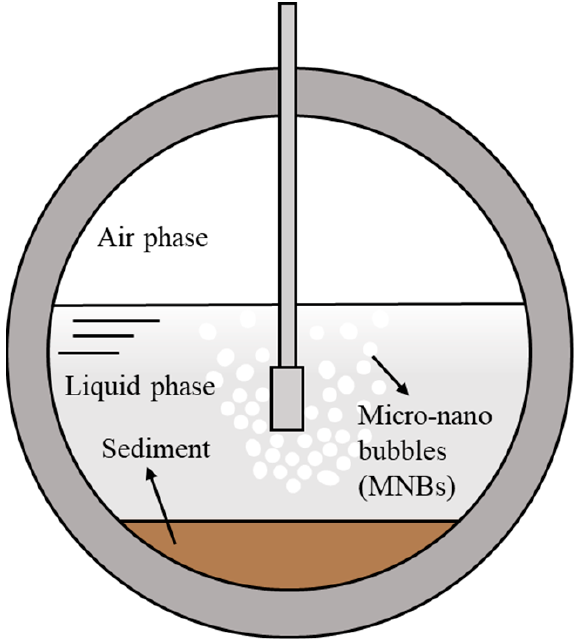
Figure 2. Schematic of the micro-nano bubbles (MNBs)(cid:31) application in drainage pipeline in situ deodorization.